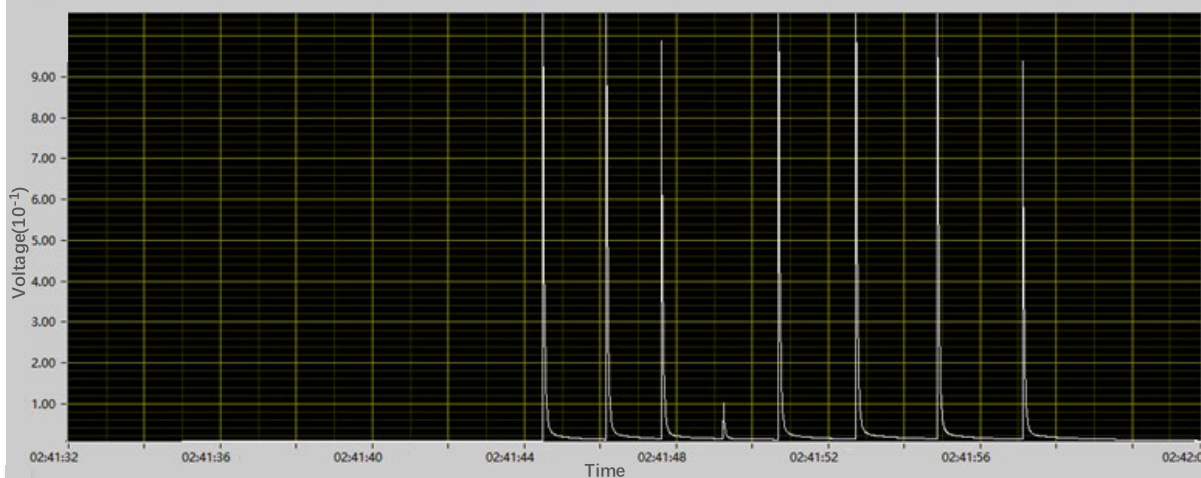
Figure 14. Sensor voltage curve under impact load.